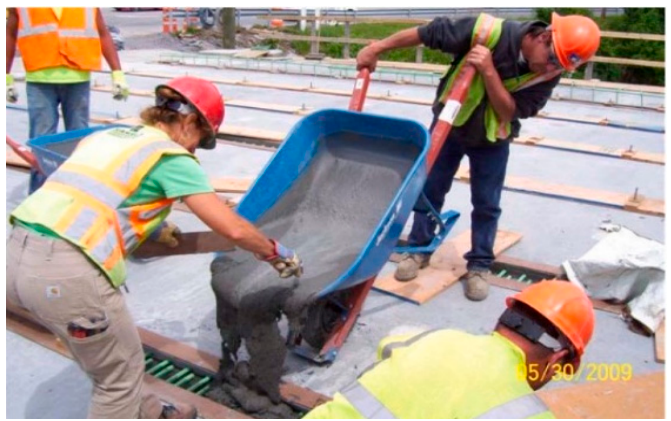
Figure 6. Representative apps of UHPC in joint connection BEs [138] . Figure 6. UHPC link slab utilized among girders on BE decks